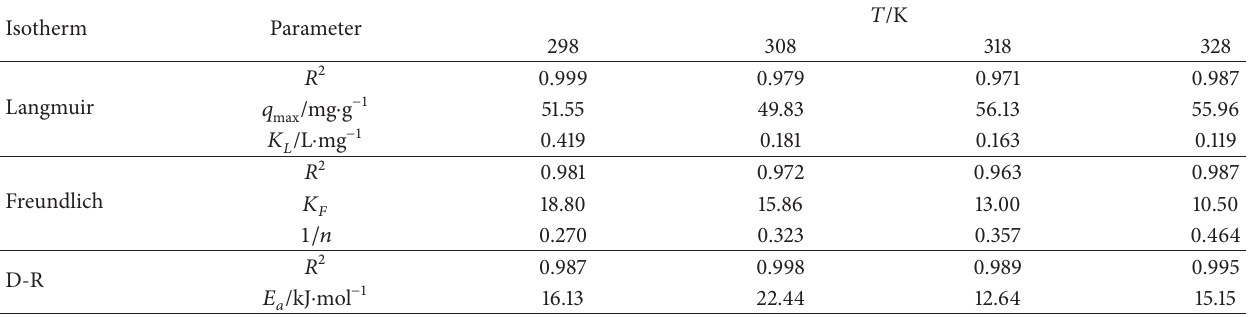
Table 4: Adsorption parameters of methylene blue on the walnut shell powder at different temperatures. Isotherm